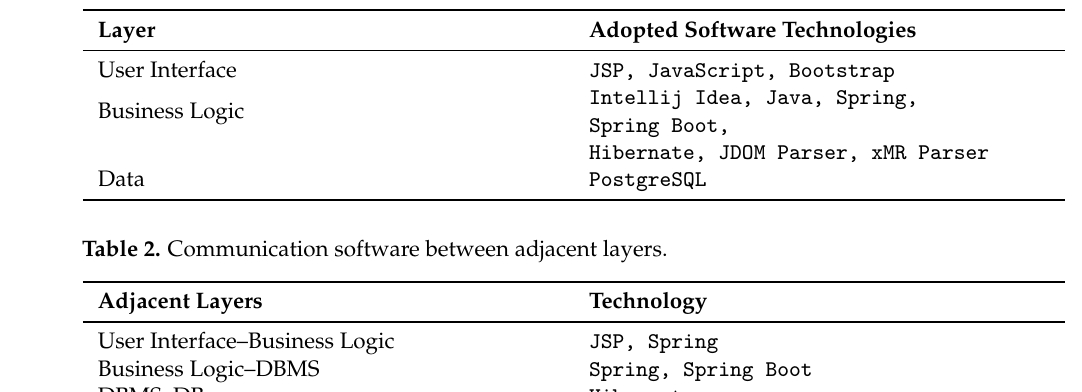
Table 1. List of the software technologies used.